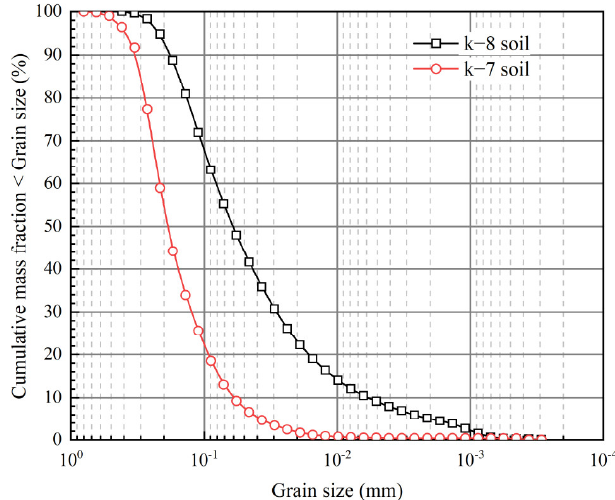
Figure 1. Grain size distributions for the soils used in the column capillary rise tests.